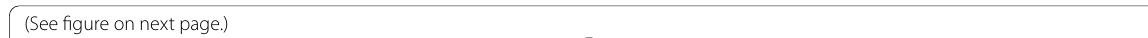
(See figure on next page.) Fig. 2 Time course of bioreactor batch cultivation of B. subtilis DSM 10 T employing 40 g/L glucose. ComX activity (white circle) is shown in the middle of the graph. The model was used to successfully describe the trajectory of one set of experimental data (black line). A high sensitivity to changes in parameters is demonstrated, as variation of parameter value less than 8% allowed for description of the entire cloud of all available data from biological and technical replicates using parameter values from Table 2 (dashed lines) from the beginning of maximum ComX